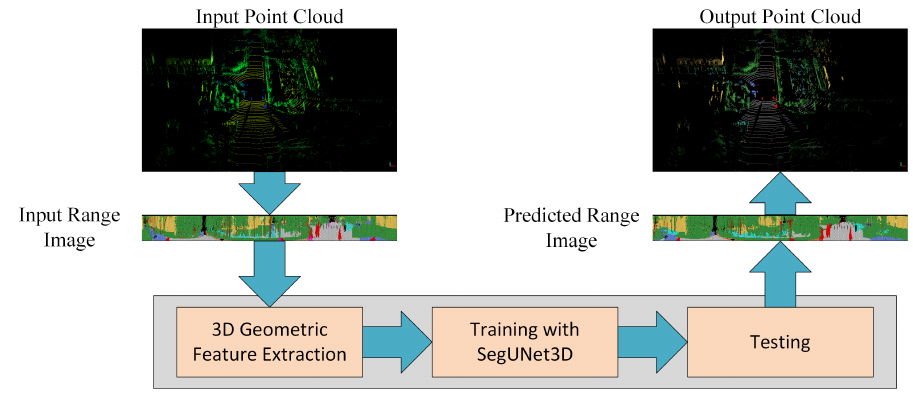
Figure 1. Workflow of the